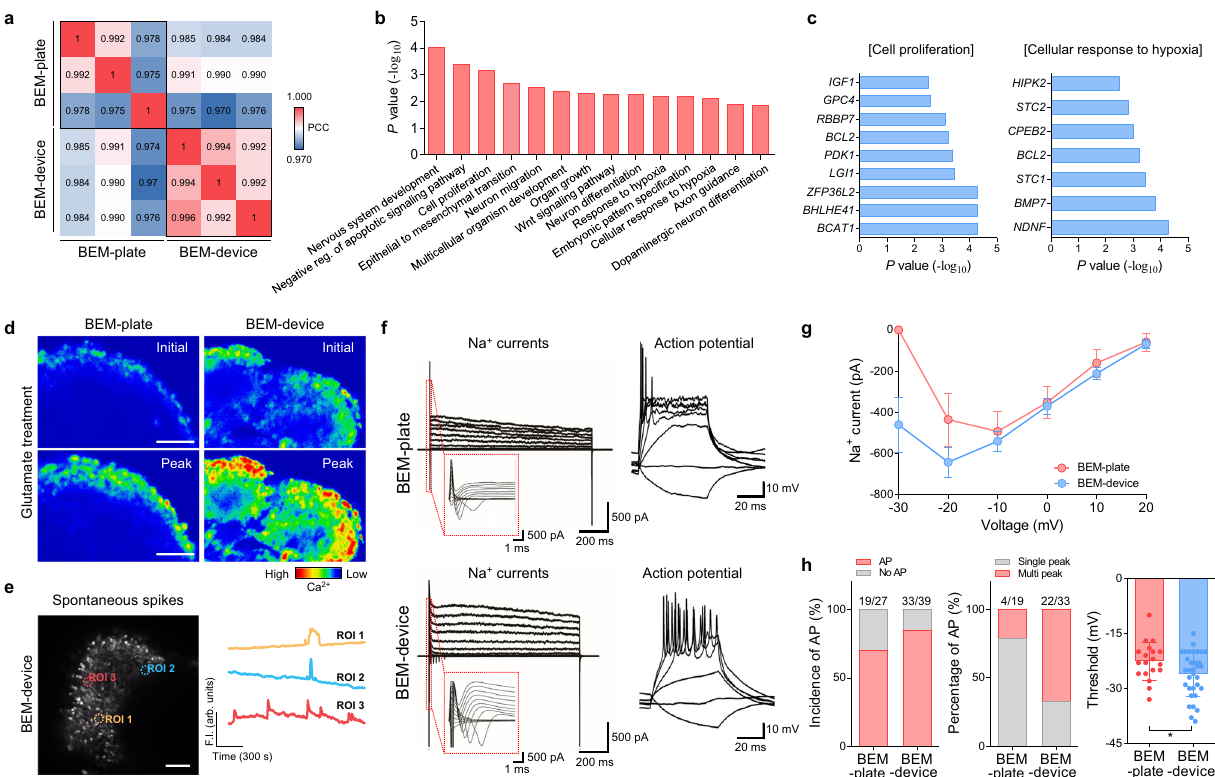
Fig. 7 The transcriptome pro fi le analyses and electrophysiological function characterization of brain organoids cultured in the micro fl uidic BEM system. a Pearson ’ s correlation matrix for whole-genome pro fi les in BEM-plate and BEM-device organoids ( n = 3, independent replicate = 1). Pearson ’ s correlation coef fi cient (PCC) values are indicated in each box. b The top 14 enriched gene ontology (GO) terms of upregulated genes in the BEM-device group versus the BEM-plate group (shown in terms of p values). c Lists of differentially upregulated genes classi fi ed in two GO functional categories; ‘ Cellular response to hypoxia ’ and ‘ Cell proliferation ’ . d Ratiometric images of calcium imaging before and after 100 μ M glutamate treatment in Fluo-4 AM- loaded BEM-plate and BEM-device organoids (scale bars = 50 μ m, independent replicates = 4). The color scale indicates fl uorescence intensity of Fluo-4 AM. e A fl uorescence image showing spontaneous calcium (Ca 2 + ) transient of cells in BEM-device organoids (left) (scale bar = 100 μ m, independent replicates = 3). Representative time-course peaks showing spontaneous changes in Fluo-4 AM fl uorescence intensity measured in cells in the BEM-device organoid (right). Traces were obtained from the region of intensity (ROI) marked on the fl uorescence image. f Representative current traces recorded in a neuron with a voltage-clamp mode (left two panels) and representative traces of evoked action potentials (APs) recorded in a neuron with a current-clamp mode (right two panels) in brain organoids grown in either a BEM-plate (top panels) or a BEM-device (bottom panels). g Quanti fi cation of sodium (Na + ) currents in response to increased voltage steps starting from − 30 mV to + 20 mV (10 mV step size) in neurons within brain organoids grown in either a BEM-plate or a BEM-device ( n = 5). h Quanti fi cation of AP incidence (BEM-plate: n = 27; BEM-device: n = 39, independent replicates = 7), spike numbers (single versus multiple) in each condition, and threshold potentials to evoke AP (BEM-plate: n = 19; BEM-device: n = 33, unpaired two-tailed t -test (* p < 0.05), BEM-plate versus BEM-device p = 0.0380). Brain organoids cultured for ( a – e ) 75 days and ( f – h ) 60 days were analyzed. All data are expressed as mean ± SD. Source data are provided as a Source Data